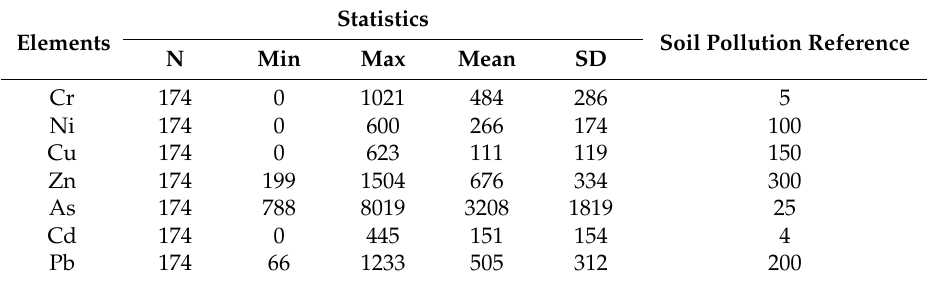
Table 1. Descriptive statistics quantity of heavy metal concentrations for the 174 samples and soil pollution reference (standard from The Ministry of Environment of Korea). Elements